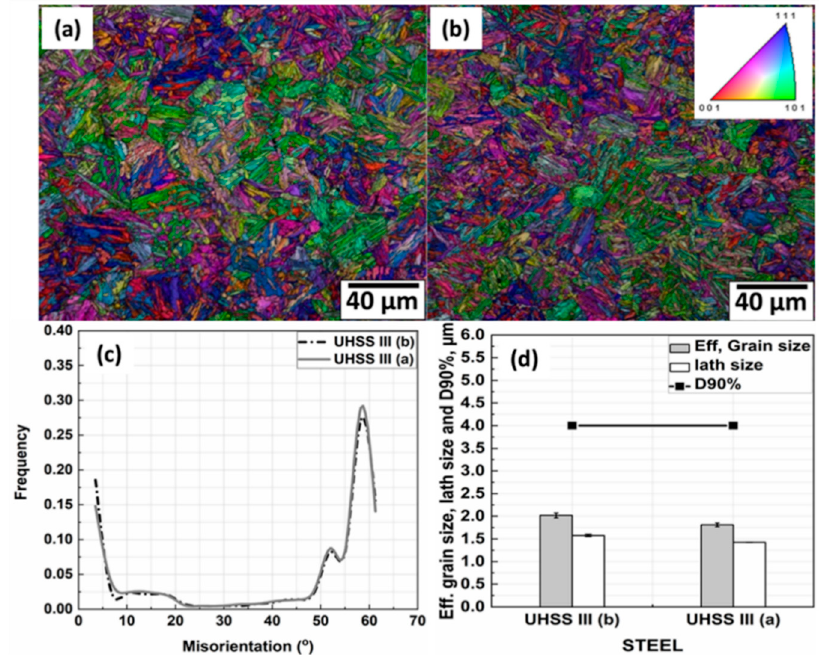
Figure 8. IPF with superimposed IQ map of forged and air-cooled bar of UHSS III without ESR ( a ) and with ESR ( b ) (scale bar is 40 µm), grain boundary misorientations ( c ), mean lath size, mean effective grain size and D90% ( d ).